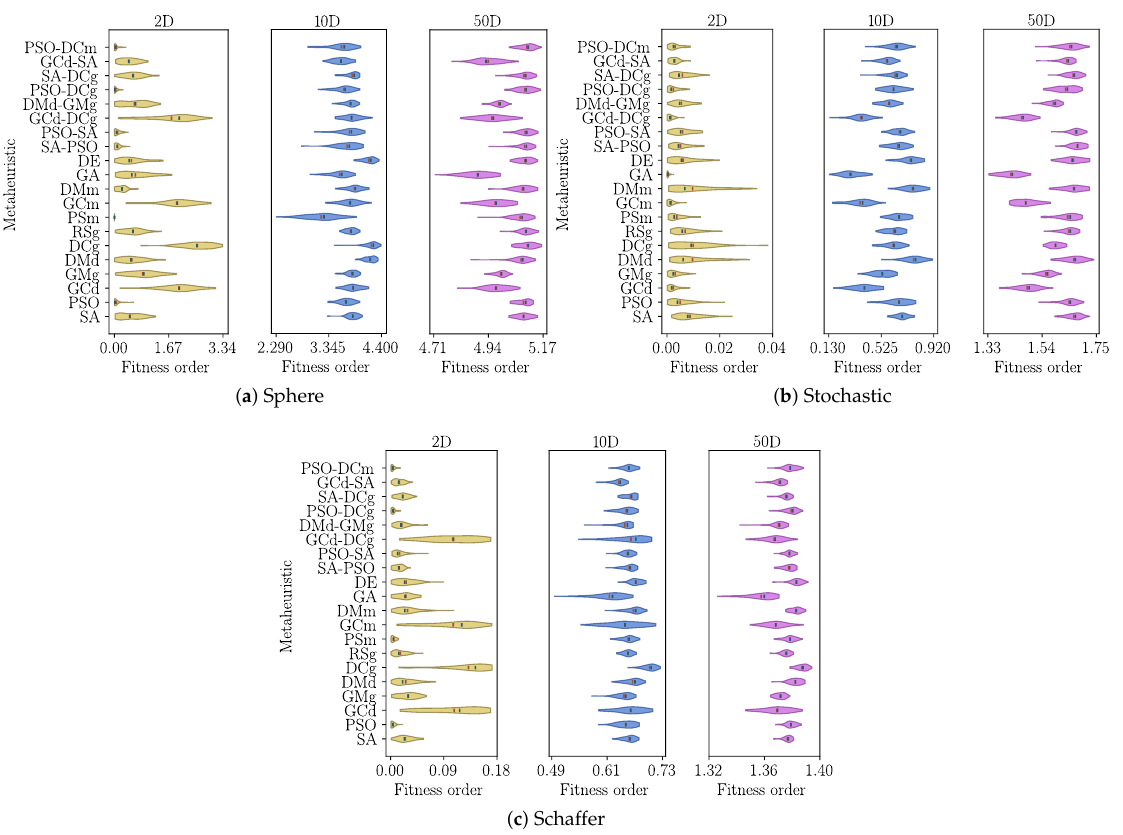
( f ( (cid:126) x ∗ )) , obtained for each metaheuristic built 10